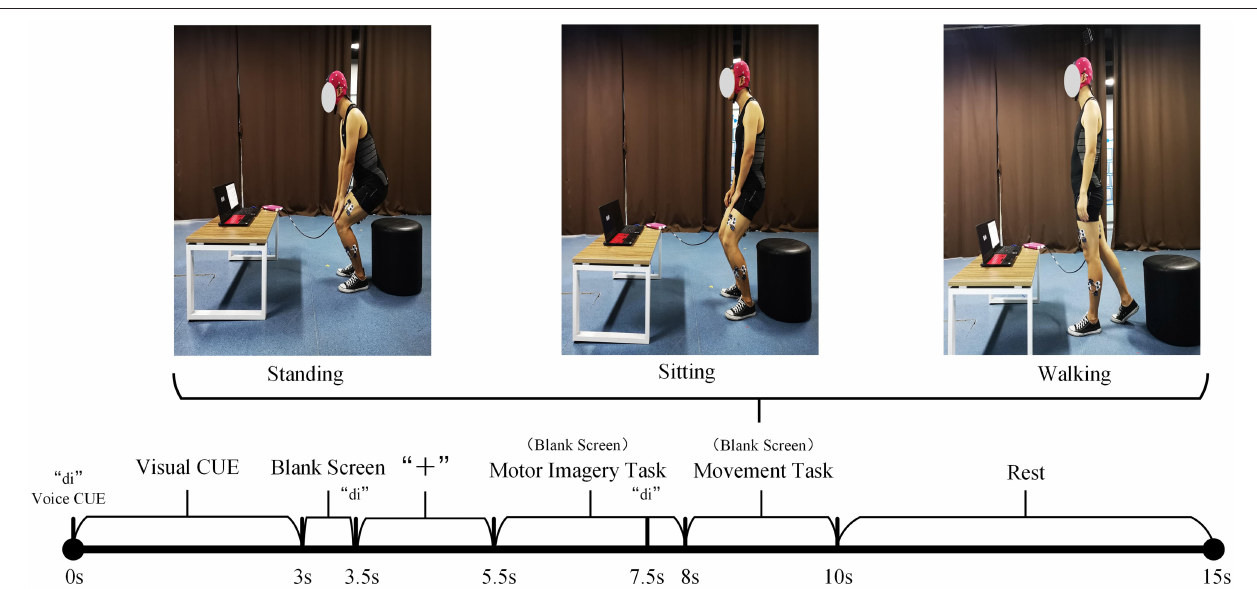
FIGURE 3 | The incomplete asynchronous acquisition paradigm of the sEMG and EEG data acquisition experiment. The upper part is the three lower limb movements. The lower part is the incomplete asynchronous acquisition paradigm of sEMG and EEG data. As can be seen from the figure, EEG signals and sEMG signals are not collected completely asynchronously. After 7.5s, the EEG signal and sEMG signal are collected simultaneously. Considering that the sEMG signal will be activated within 0.5–1 s before the action is performed, and the subject needs a period of time to respond to the sound prompt, this paper believes that the sEMG signal and EEG signal collected simultaneously in 7.5–8.5 s have an important role in the prediction of the lower limb movement of hemiplegia. According to the definition in Section 3.1, X EEG 1 is the EEG signal data collected in the period of 5.5–7.5s. X EEG 2 , X sEMG are the EEG and sEMG signal data collected simultaneously during the 7.5–8.5 period,